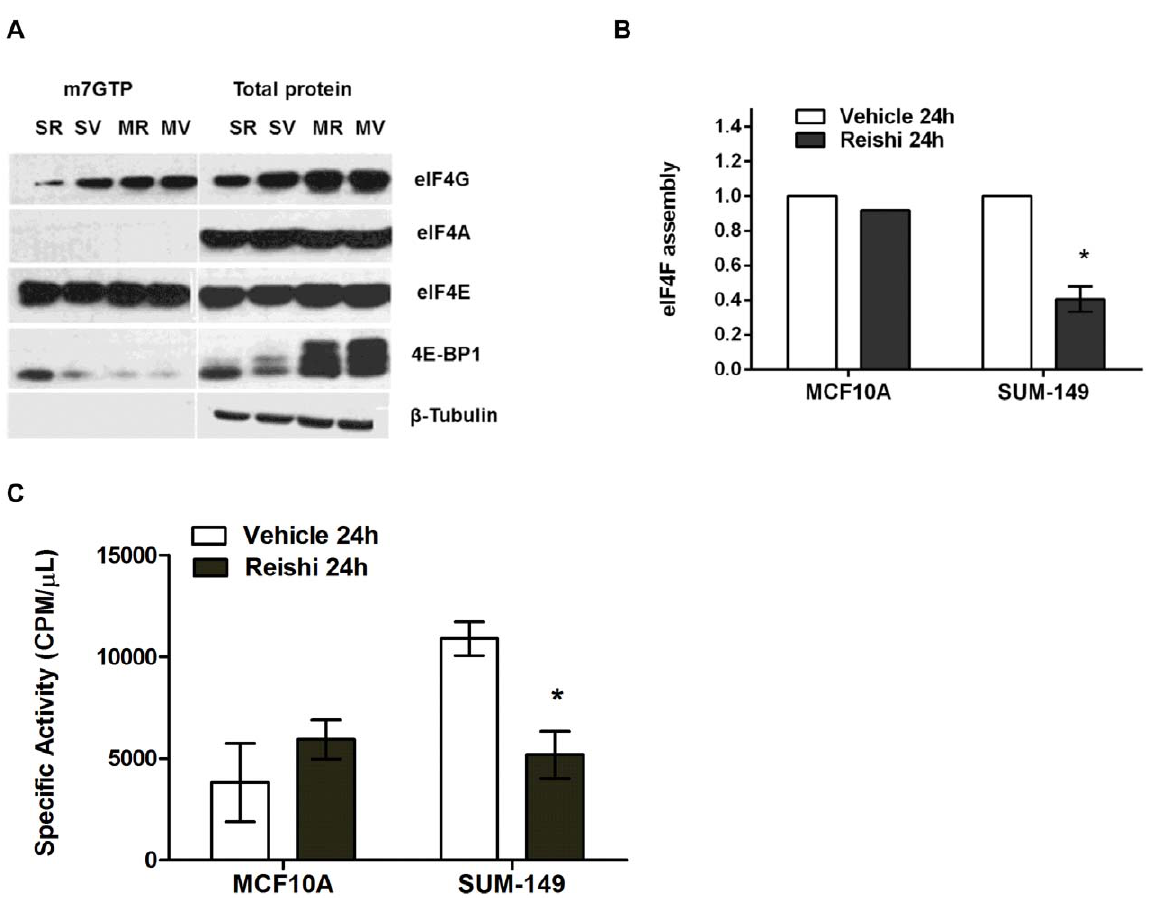
Figure 2. Reishi decreases EIF4F complex levels and protein synthesis in IBC cells. A. SUM-149 and MCF10A cells were treated with vehicle (0mg/mL, SV or MV) or 0.5mg/mL Reishi (SR or MR) for 24 hours before lysis. Western blot analyses were completed for total eIF4G, eIF4A, eIF4E, and 4E-BP1 obtained from m7GTP pull-down lysates and whole cell lysates. B. Graph represents quantification of eIF4F complex as in Dumstorf et al., 2010 [25], where eIF4G normalized to eIF4E is divided by 4E-BP1 normalized to eIF4E [(eIF4G/eIF4E)/(4E-BP1/eIF4E)]. Number of biological replicates (n) varies among experiments (SUM-149; n=3, MCF10A; n=1). Columns show means 6 SEM of integrated density units, shown relative to vehicle controls. Reishi significantly reduces eIF4F complex assembly at * P , 0.02 in IBC SUM-149 cells. C. 1 6 10 5 cells (SUM-149 and MCF10A) were seeded per well in a six well plate and treated with vehicle or 0.5 mg/mL Reishi for 24 hours. The treatment was removed and the cells were re-incubated for 30 minutes in methionine/cysteine - free DMEM. L-[ 35 S] Methionine and L-[ 35 S] Cysteine (2 mCi/mL) + 2% FBS was then added to the cultures. Total